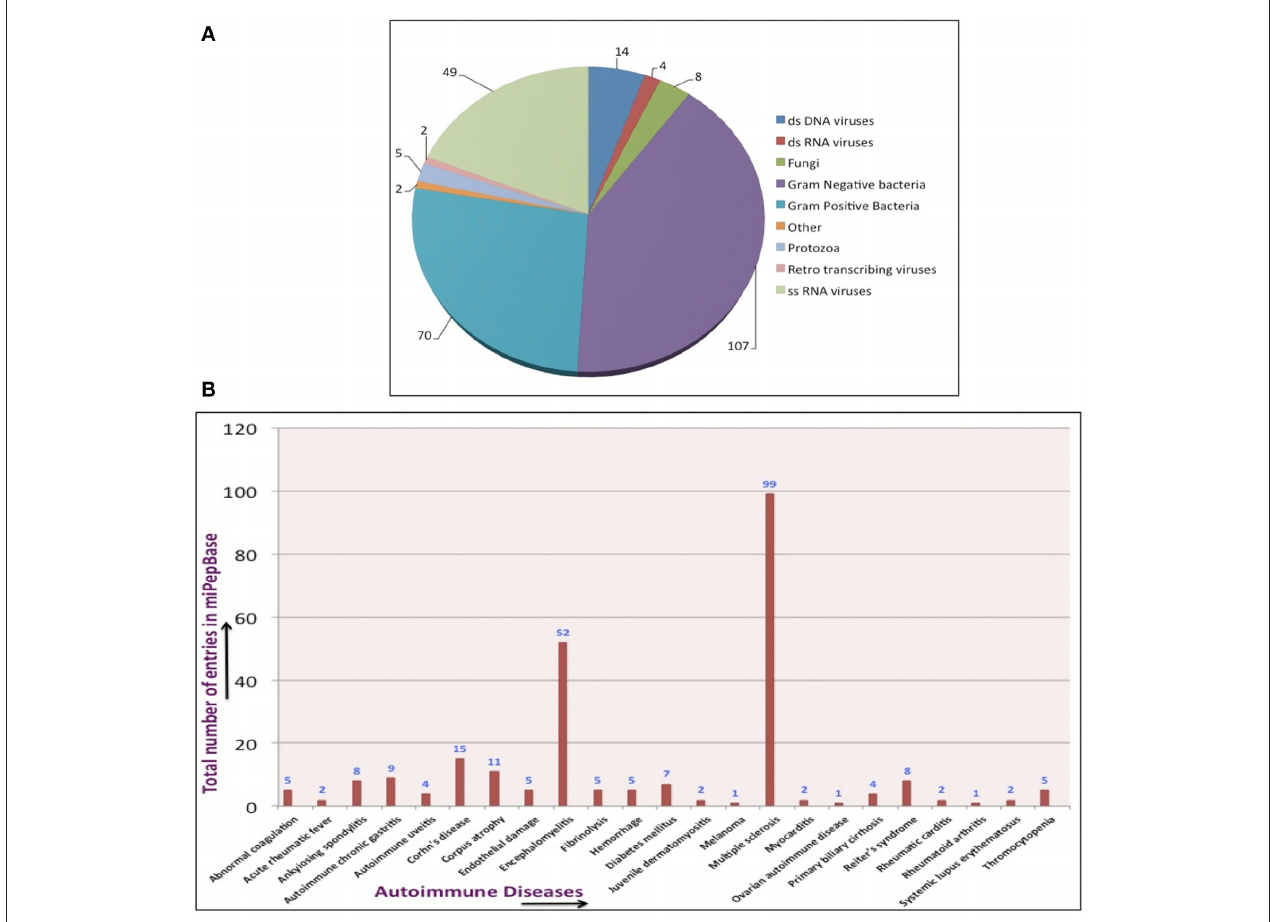
FIGURE 2 | Data statistics (A) Based on pathogen taxonomic group, (B) Based on autoimmune